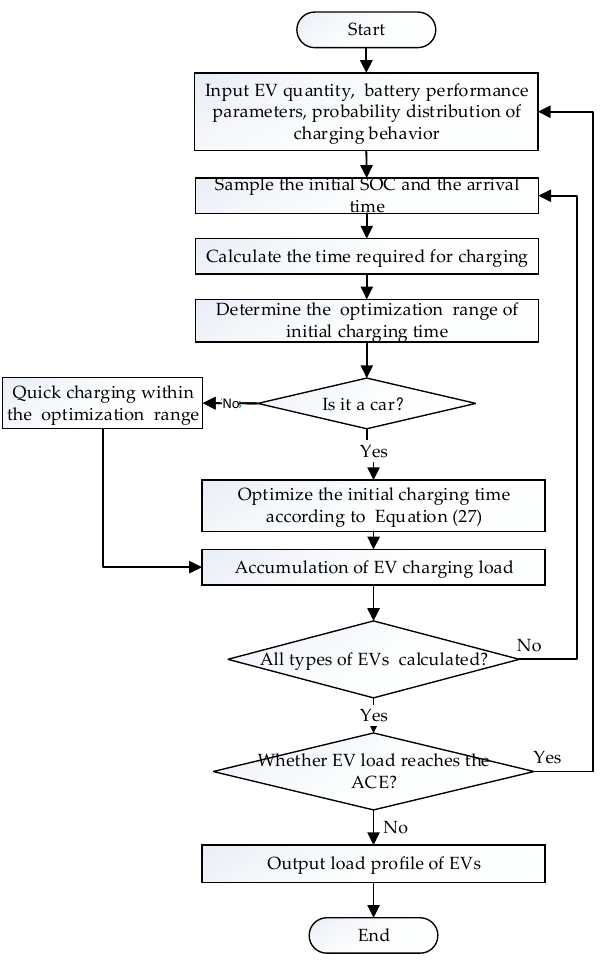
Figure 6. Flowchart of the optimization procedure.